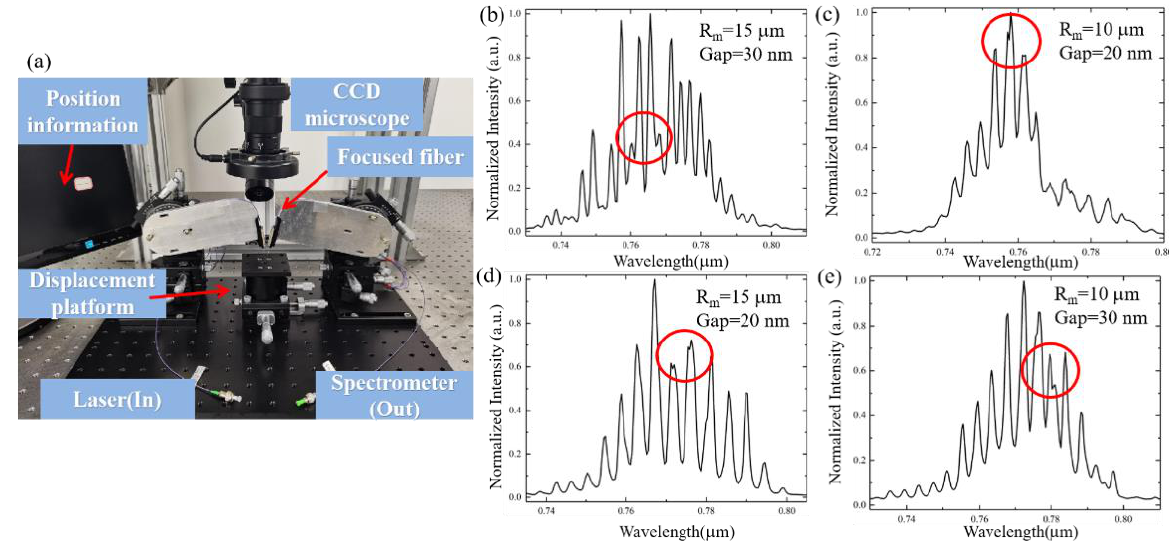
Figure 4. ( a ) Schematic diagram of test platform. ( b ) R m = 15 µ m, Gap = 30 nm, ( c ) R m = 10 µ m, Gap = 20 nm, ( d ) R m = 15 µ m, Gap = 20 nm. ( e ) R m = 10 µ m, Gap = 30 nm.